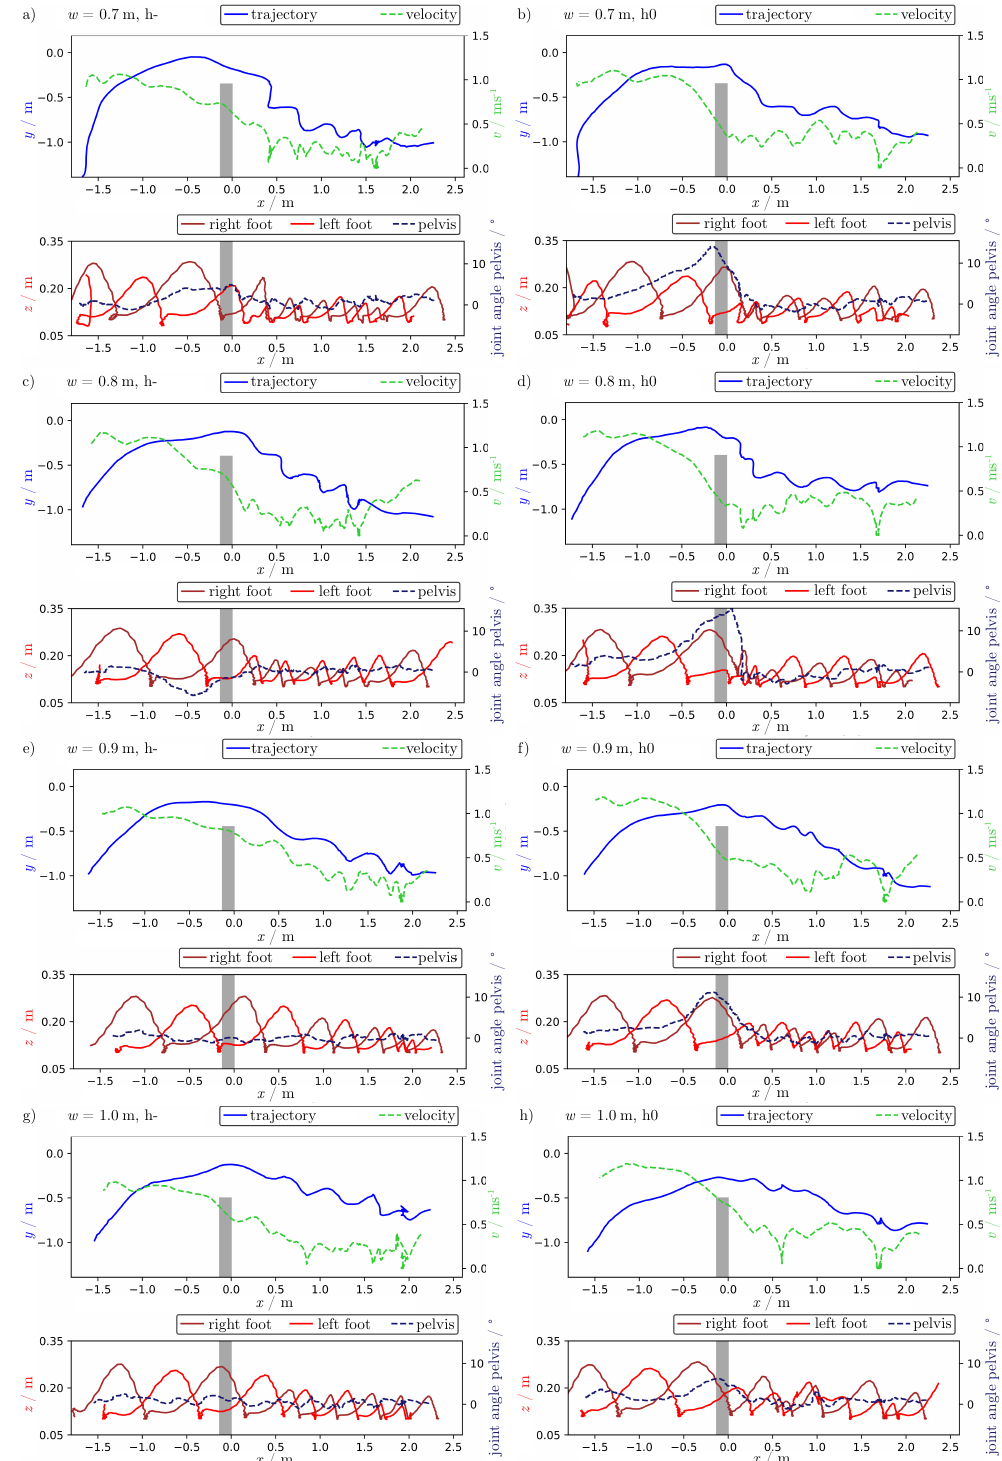
Figure 9. Head position (blue), velocity (dashed green), foot position (red) and joint angle of pelvis (dashed dark blue) for increasing bottleneck widths w (top to bottom) and low (h-, left) and high (h0, right) motivations: ( a ) 0.7m, h-, ( b ) 0.7m, h0, ( c ) 0.8m, h-, ( d ) 0.8m, h0, ( e ) 0.9m, h-, ( f ) 0.9m, h0, ( g ) 1.0m, h- and ( h ) 1.0m,